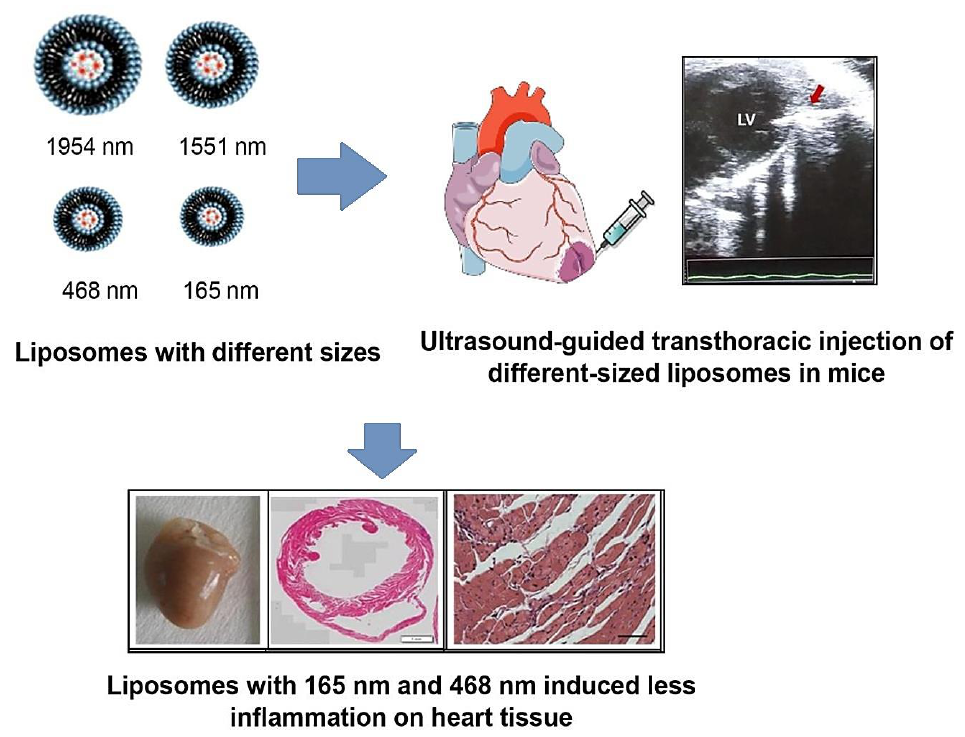
Figure 3. Liposome-based systems for targeted delivery of biopharmaceuticals in heart diseases, with related inflammation on heart tissue. Adapted from Ref. [75] with permission. Copyright 2022 Elsevier.